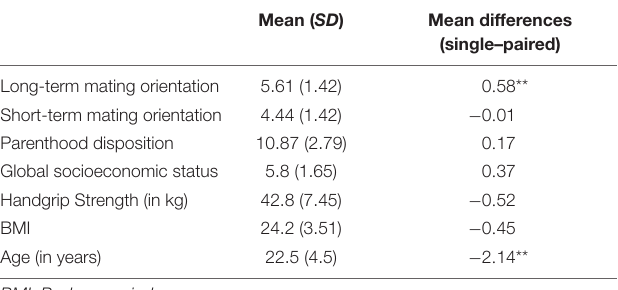
TABLE 1 | Mean, standard deviation, and mean differences between paired ( N = 112) and single ( N = 85) individuals for each variable. Mean ( SD )